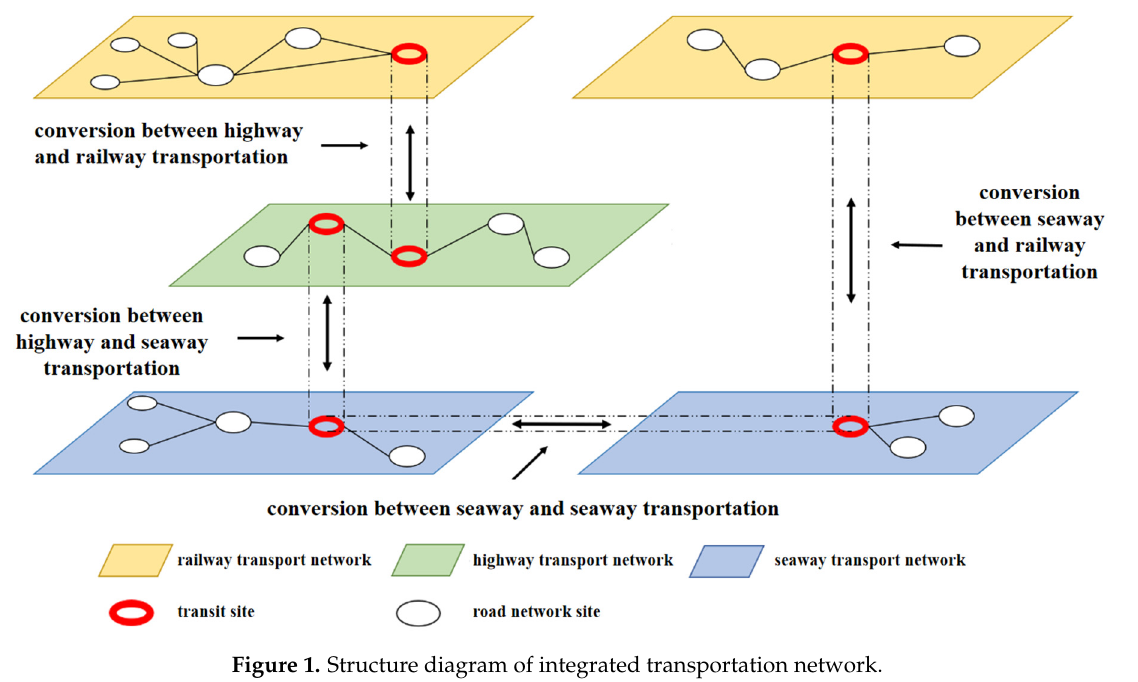
Figure 1. Structure diagram of integrated transportation network.